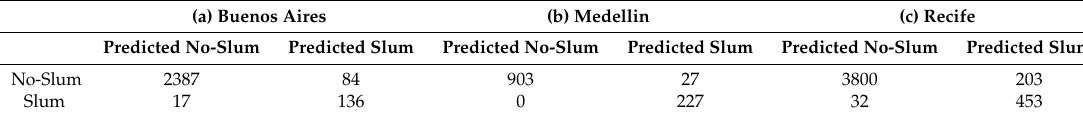
Table 8. Confusion Matrix of the SVM rbk with the parameters reported in Table 7.